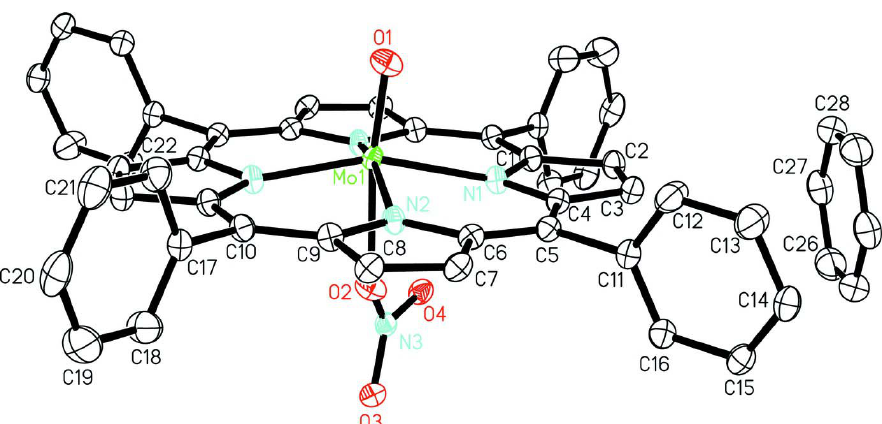
Figure 1 The molecular structure of (I) with displacement ellipsoids drawn at the 30% probability level (H atoms omitted for clarity). The unlabelled atoms of the complex and the benzene molecule are generated by the symmetry operations (1- x , 1- y , 1- z ) and (- x , - y , 1- z ),